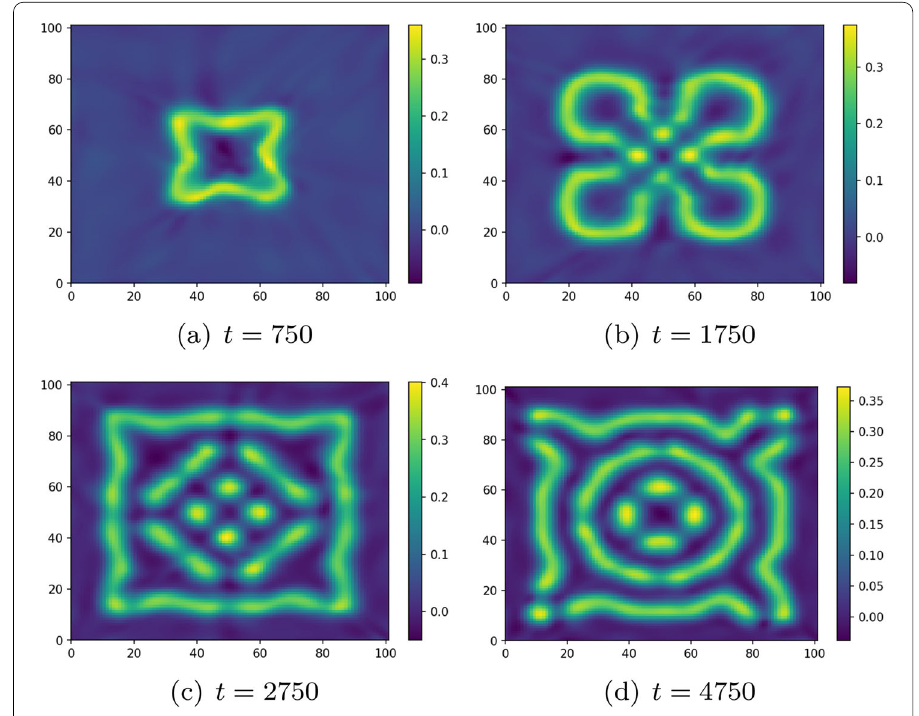
Fig. 8 Example of Solitonpatterns . The parameters used in the (3) are F = 0 . 030 and K = 0 . 060. The times shown are: t = 750 , 1750 , 2750 , 4750